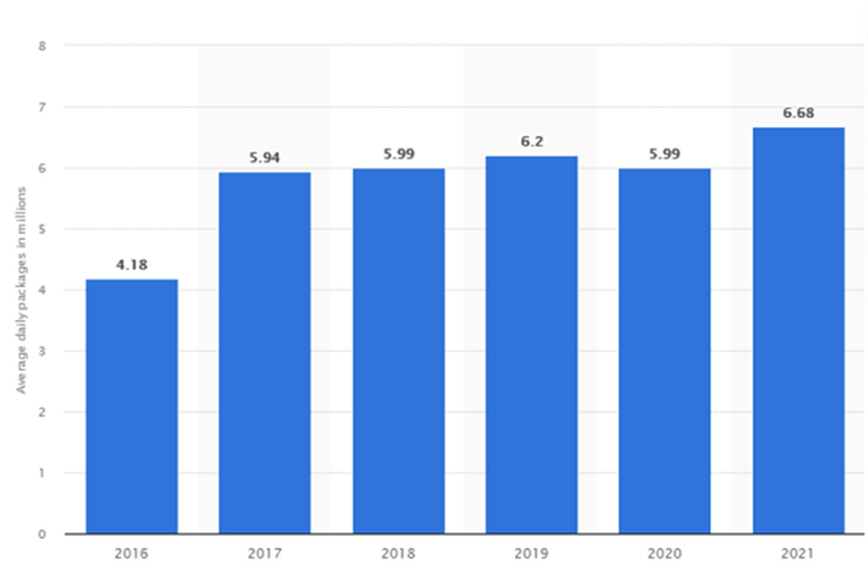
Figure 1. Number of daily packages delivered from FedEx [1].